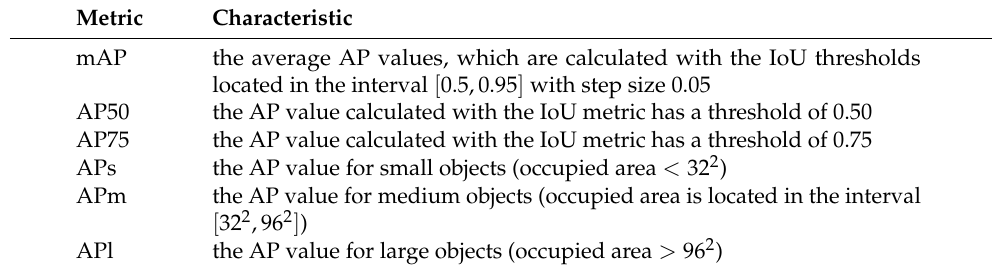
Table 1. The employed evaluation metrics.